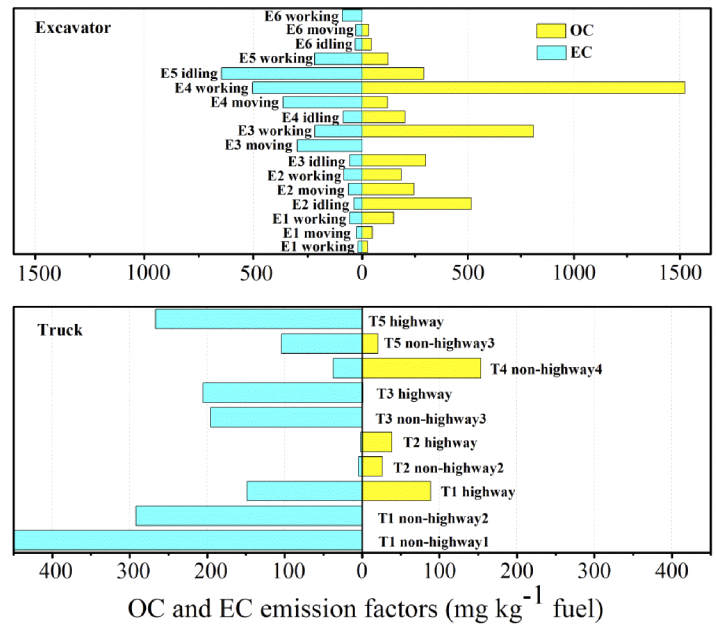
Figure 6. OC / EC ratios in different operational modes and driving conditions for excavators and